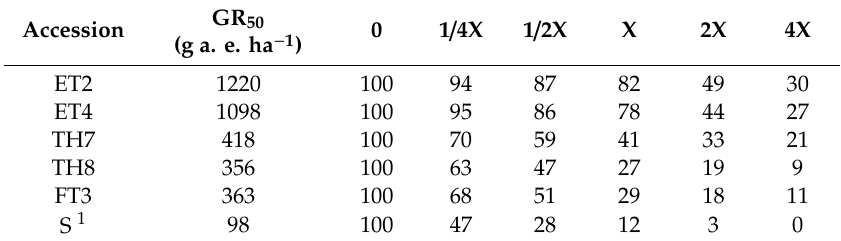
Table 5. Dry weight and GR 50 of E. colona accessions after application of glyphosate at di ff erent rates. The measurement was carried out at 21 days after treatment (21 DAT). Dry weight of each accession was expressed as % of